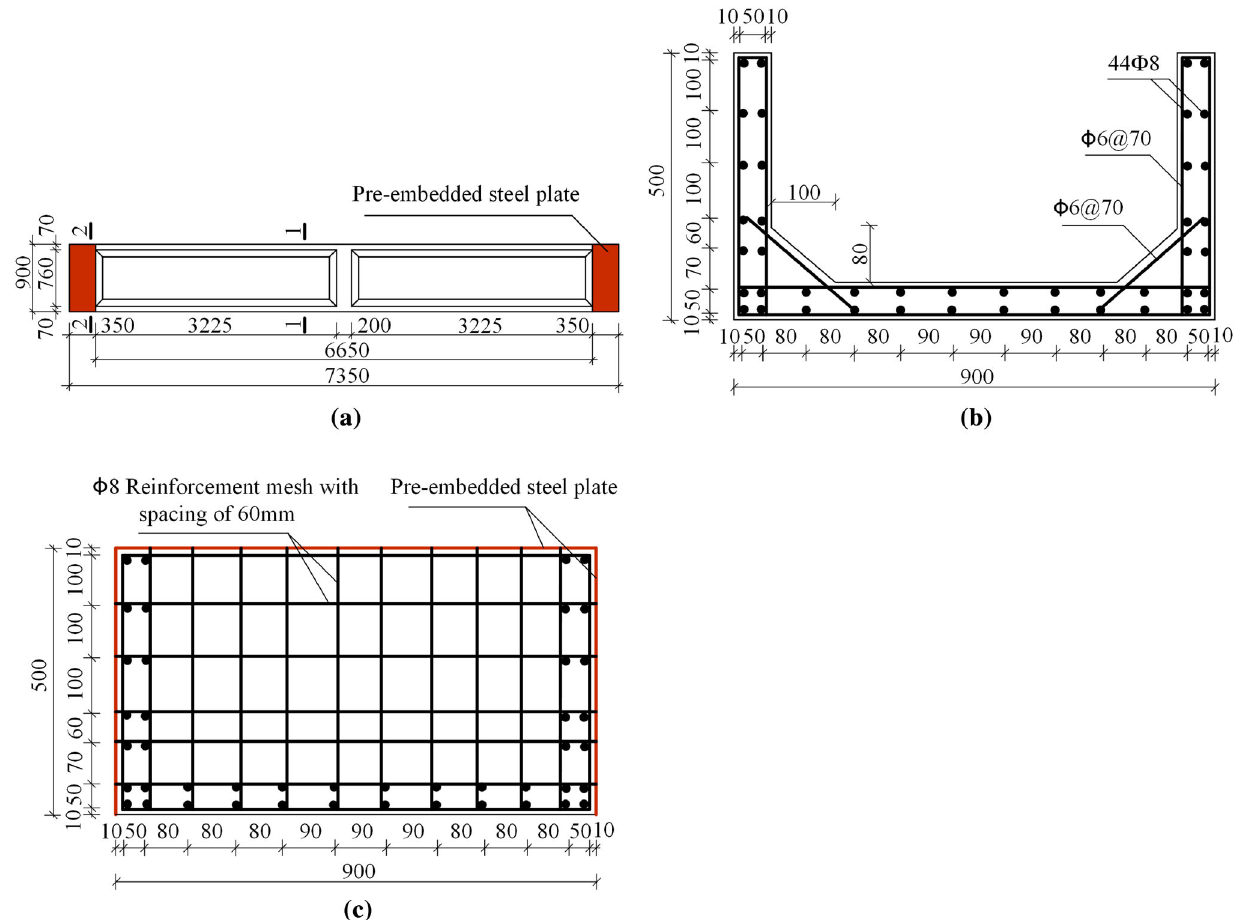
Fig. 1 Information of U-shaped thin-walled RC beam specimens (unit: mm). a Top view of U-shaped thin-walled RC beams, b detailed information of cross-Sect. 1-1, and c detailed information of cross-Sect.